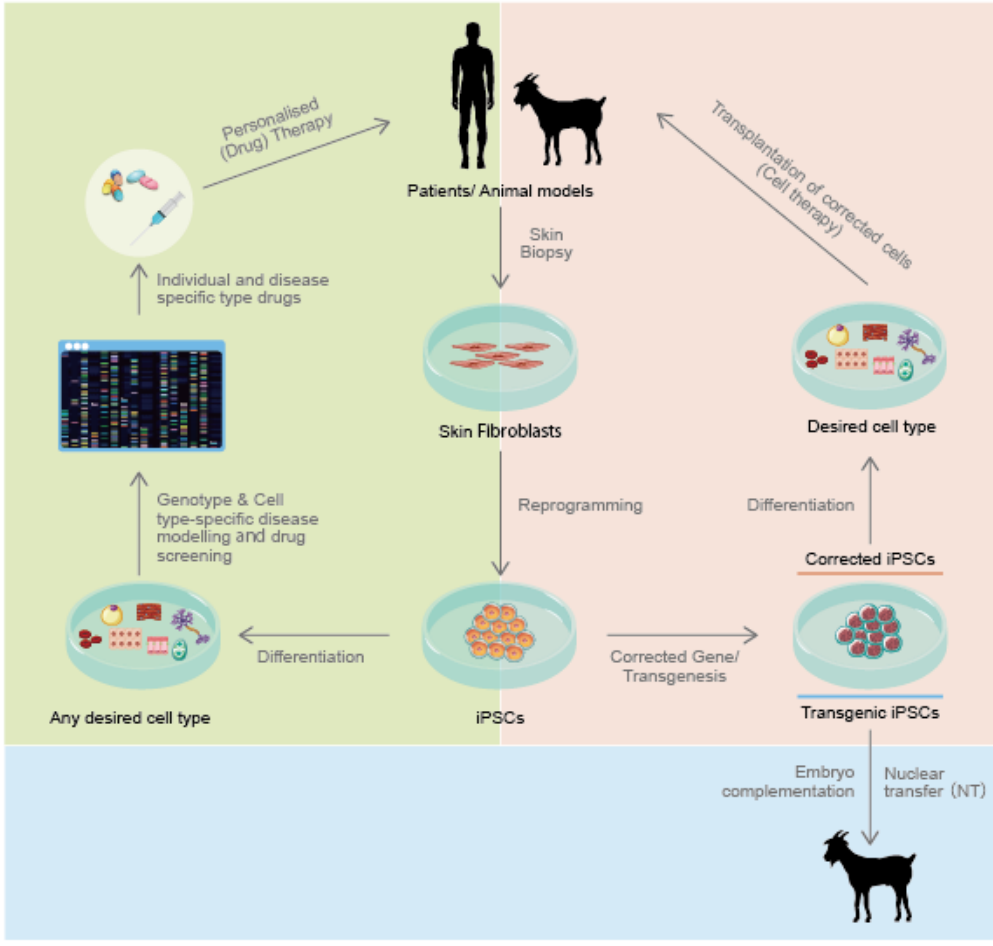
Figure 4. Most promising applications of iPSCs.